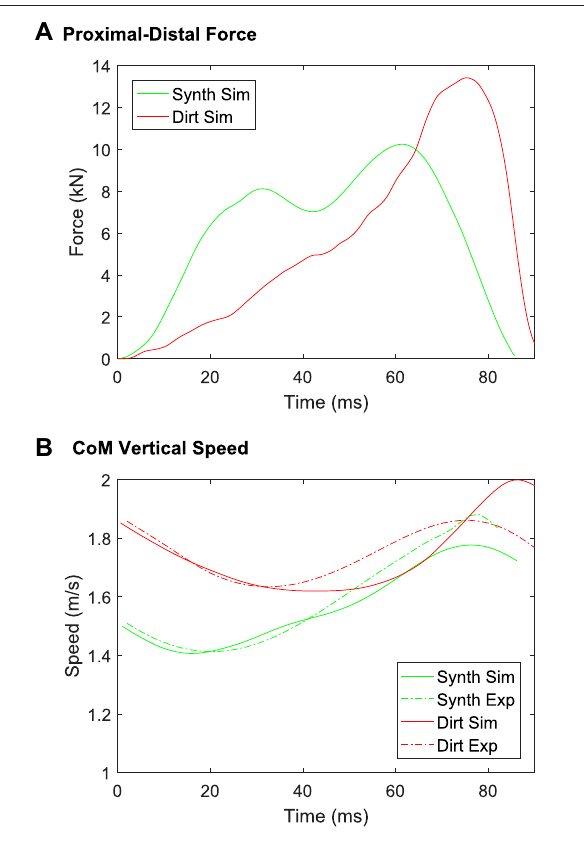
FIGURE 13 | B-SPH model predictions of (A) ground reaction force and (B) centre of mass (CoM) speed in the proximal-distal (vertical) direction, for the synthetic and dirt track